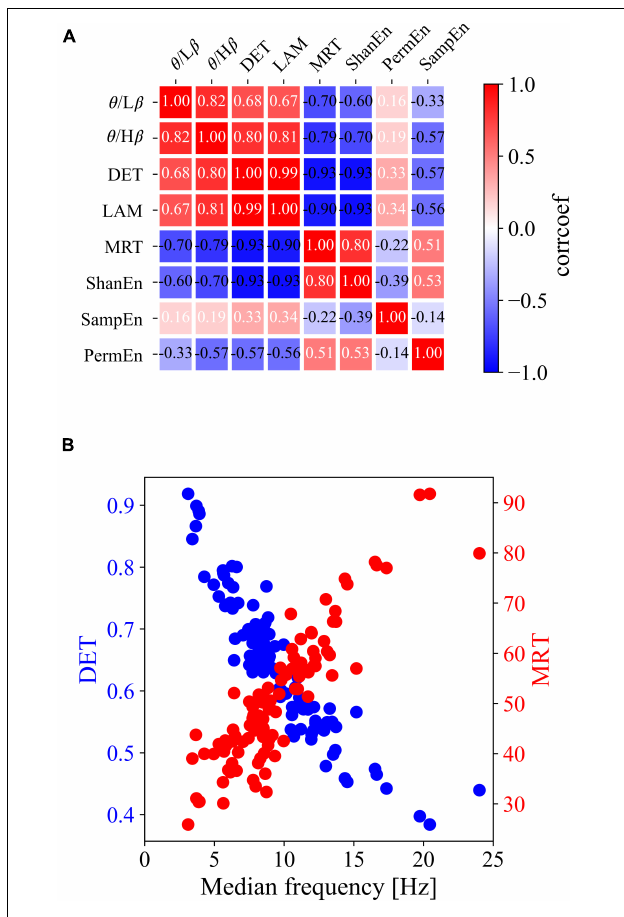
FIGURE 3 | Linear relationship among all types of prior EEG features at the F3 site. (A) Matrix of linear correlation coefficients between all pairs of EEG features. (B) Scatterplots of the DET and MRT with median